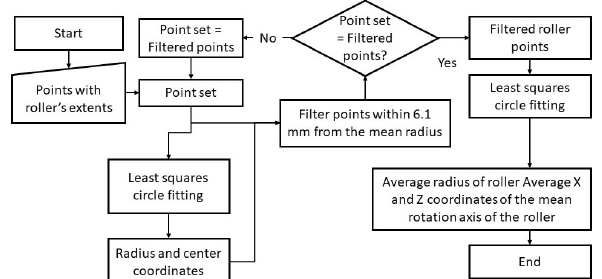
Figure 12. Flowchart to determine roller’s points, average diameter, and the location of the mean rotation axis.